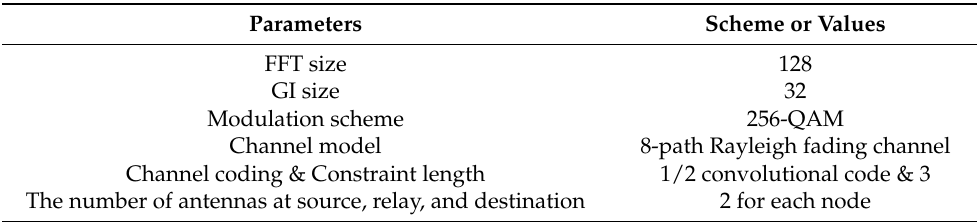
Table 3. The simulation